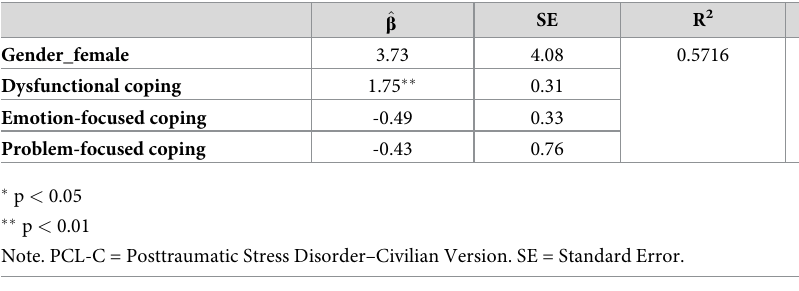
Table 4. Frequentist linear regression analysis with PCL-C score as the dependent